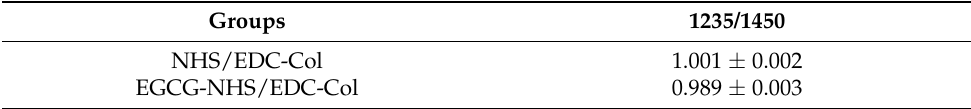
Table 3. FTIR ratio at the bands of 1235 and 1450 cm − 1 .